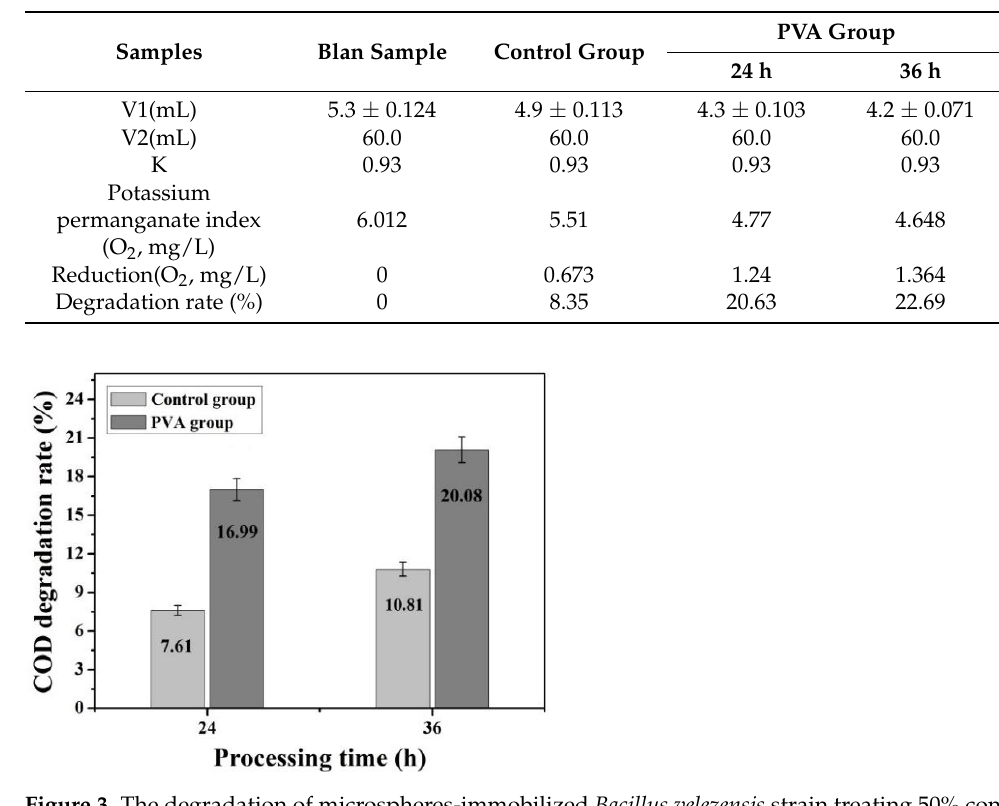
Figure 3. The degradation of microspheres-immobilized Bacillus velezensis strain treating 50% con- centration slaughter wastewater. Table 3. The degradation of microspheres-immobilized Bacillus velezensis strain treating 20% con- centration slaughter wastewater.